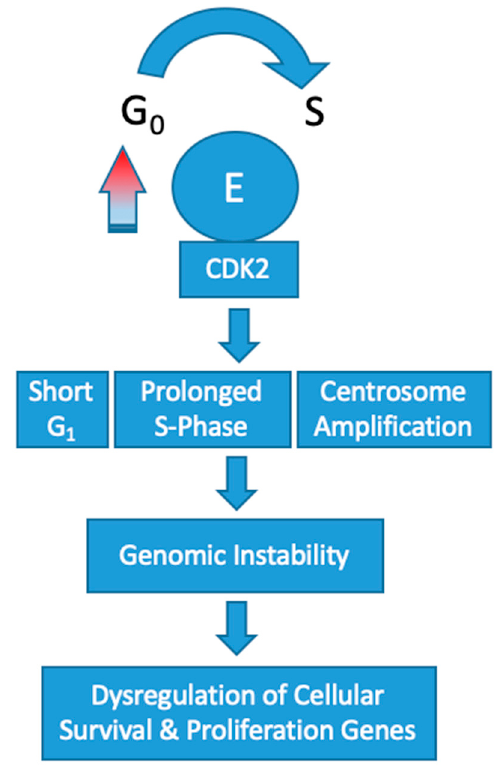
Figure 2. Schematic representation of the impact of CCNE1 amplification on oncogenesis. Adapted from Hwang, H. et al. [39].